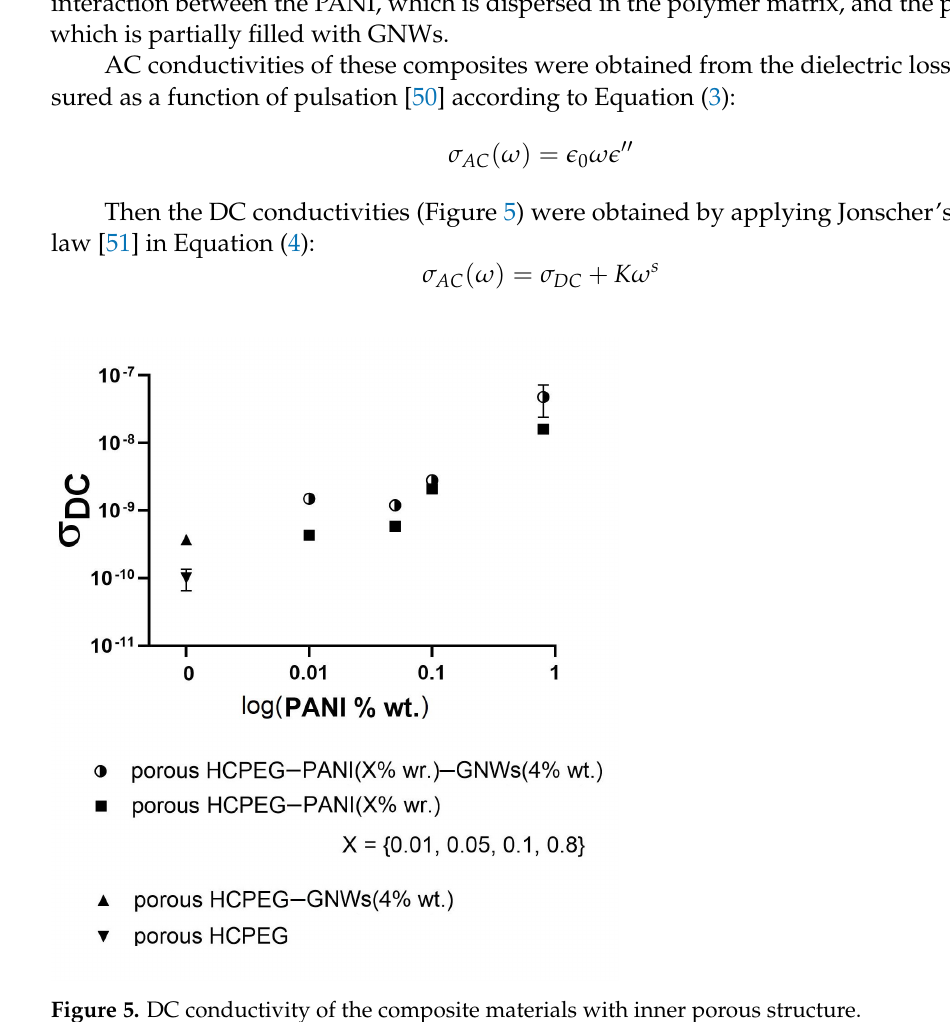
Figure 5. DC conductivity of the composite materials with inner porous